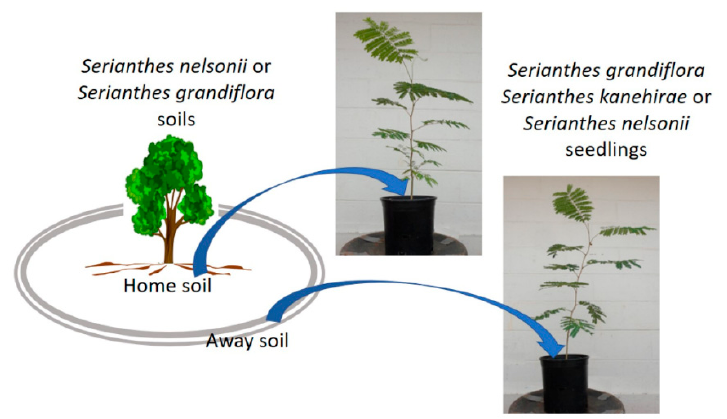
Figure 2. Field collection of Serianthes rhizosphere soils (Home) and nearby soils (Away) and ap- pearance of experimental Serianthes plants .